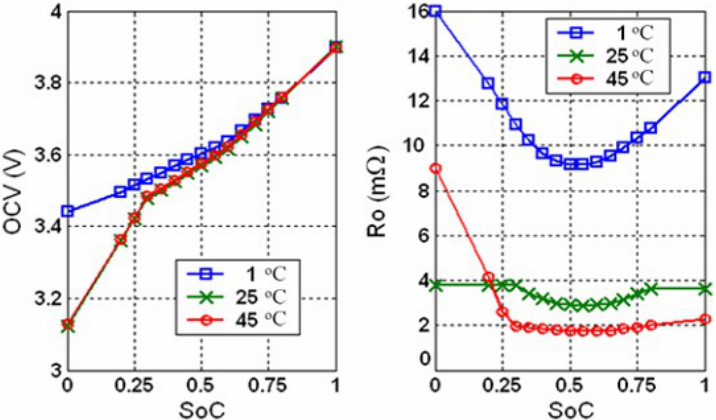
Figure 7. Battery time-variant properties. Taking OCV and Ro as examples. Data source: Advisor.